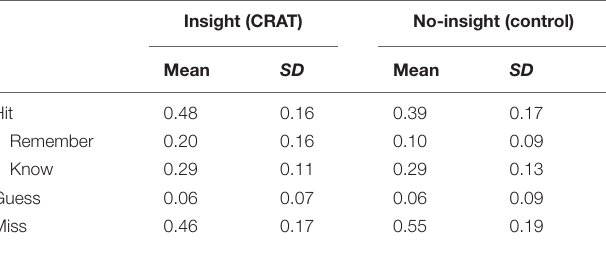
Insight (CRAT) No-insight (control)